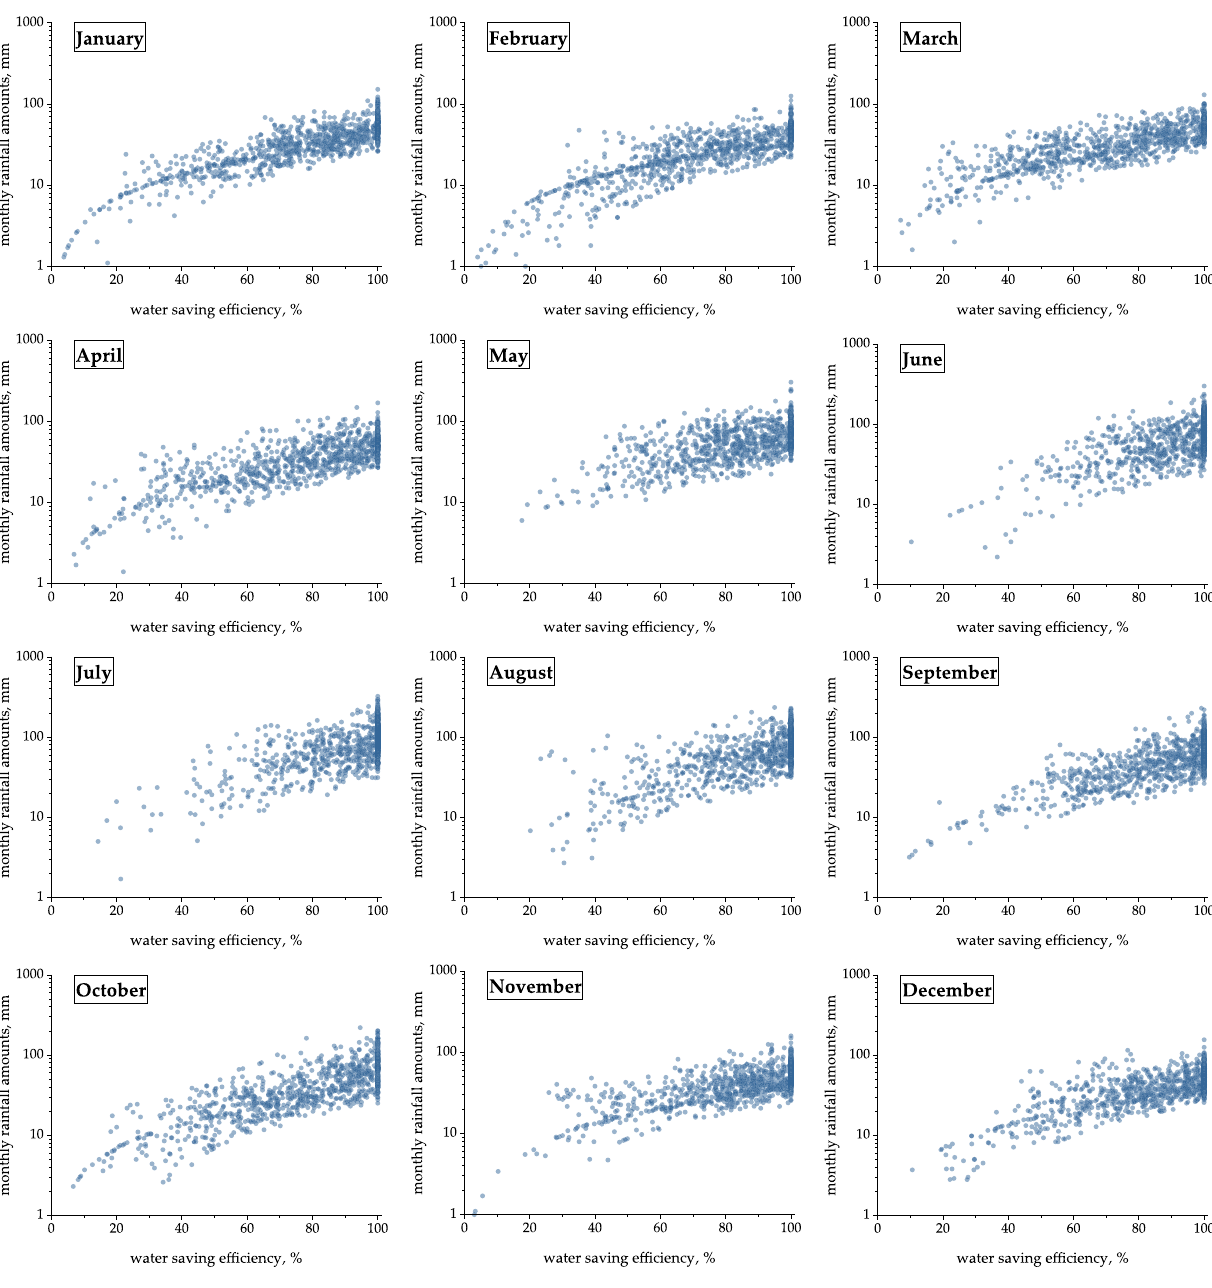
Fig. 7 Monthly performance of RHW system depending on the amount of